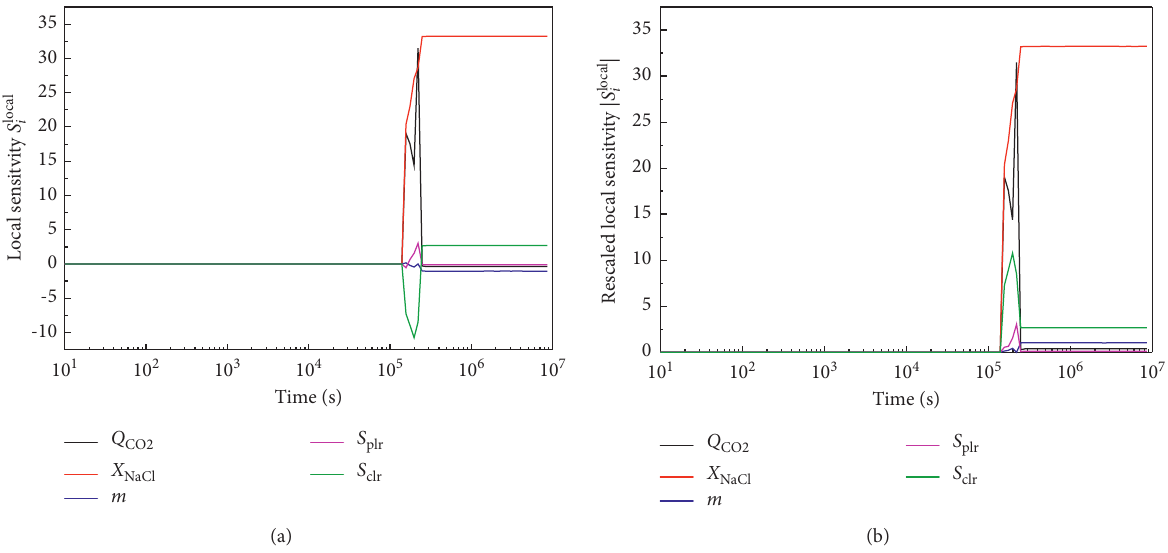
i , the thin lines represent the 95% confidence intervals.